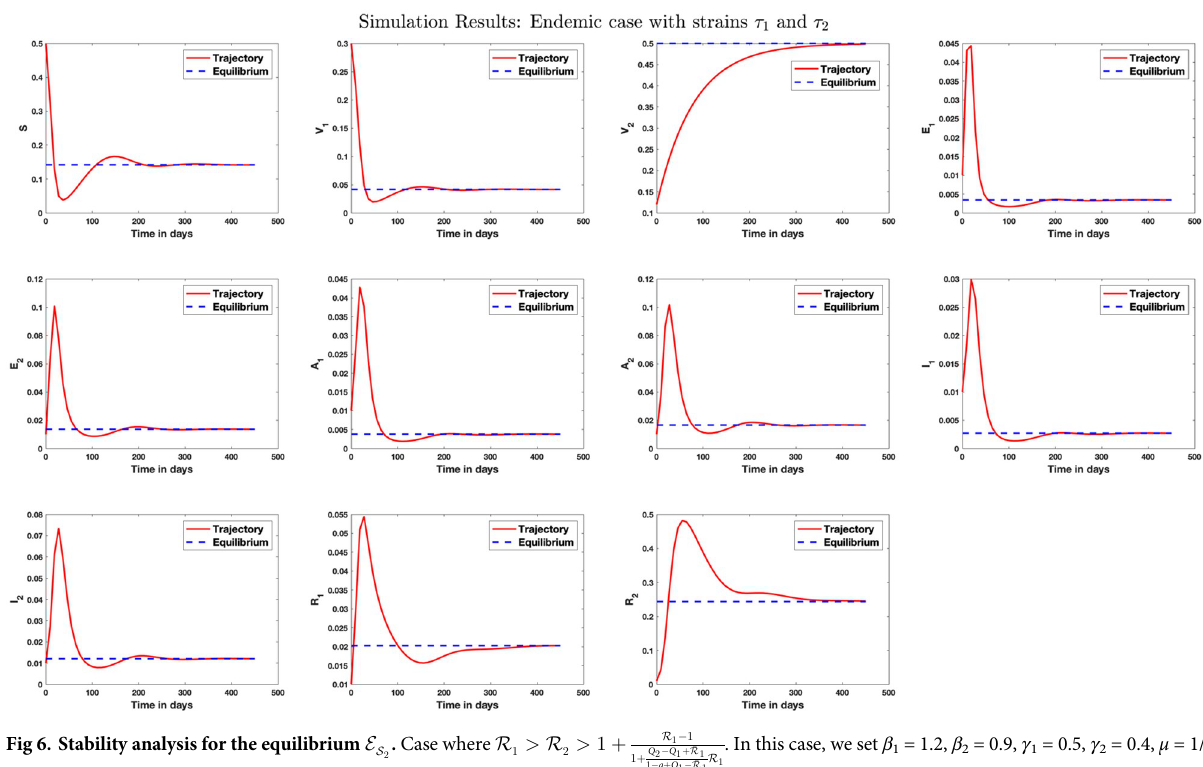
Fig 6. Stability analysis for the equilibrium E . Case where R > R > 1 þ R 1 (cid:0) 1 . In this case, we set β 1 = 1.2, β 2 = 0.9, γ 1 = 0.5, γ 2 = 0.4, μ = 1/ 1 2 S 2 1 þ Q 2 (cid:0) Q 1 þ � R 1 1 (cid:0) q þ Q R 1 1 (cid:0) � R 1 ¼ 2 : 81 and R ¼ 2 : 45 so that R ¼ 2 : 81 . We see in 80.3, q 1 = 0.1, q 2 = 0.5, λ 1 = 1/5, λ 2 = 1/4, r 1 = 1/10.5, r 2 = 1/9, θ 1 = 0.09, θ 2 = 0.1. In this case, R 1 2 0 this case that 1 þ R 1 (cid:0) 1 ¼ 1 : 10 and R > R > 1 þ 1 2 1 þ Q 2 (cid:0) Q 1 þ � R 1 1 (cid:0) q þ Q R 1 1 (cid:0) � R 1 endemic with both strains 1 and 2 because the population is already in an endemic state with strain 1 before strain 2 caused an endemic, and the number of secondary infection caused by strain 2 is more than 1